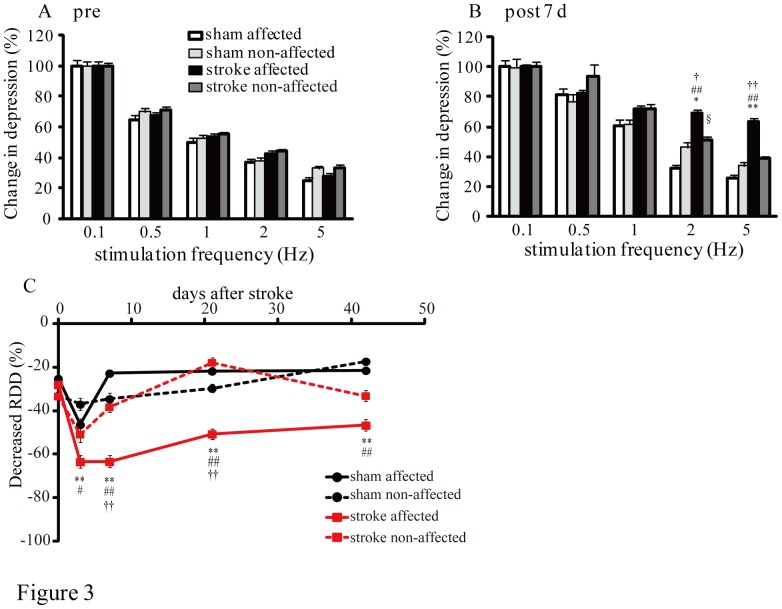
Changes in H reflex RDDs after stroke.A: RDDs of the H reflexes at baseline (pre-stroke). B: Changes in RDDs of the H reflex 7 d post-stroke in sham and stroke animals. Data are presented as percentages relative to the mean amplitude at 0.1 Hz in the same test. C: Changes in RDDs of the H reflex with 5 Hz stimulation on the affected and non-affected sides in stroke and sham mice. Error bars indicate S.E.M. One-way ANOVA with post hoc Tukey-Kramer tests, ##p<0.01, between stroke-affected and sham-affected sides, *p<0.05 and **p<0.01, between stroke-affected and sham non-affected sides, †p<0.05 and ††p<0.01, between stroke-affected and stroke non-affected, §p<0.05, between stroke non-affected and sham-affected sides.